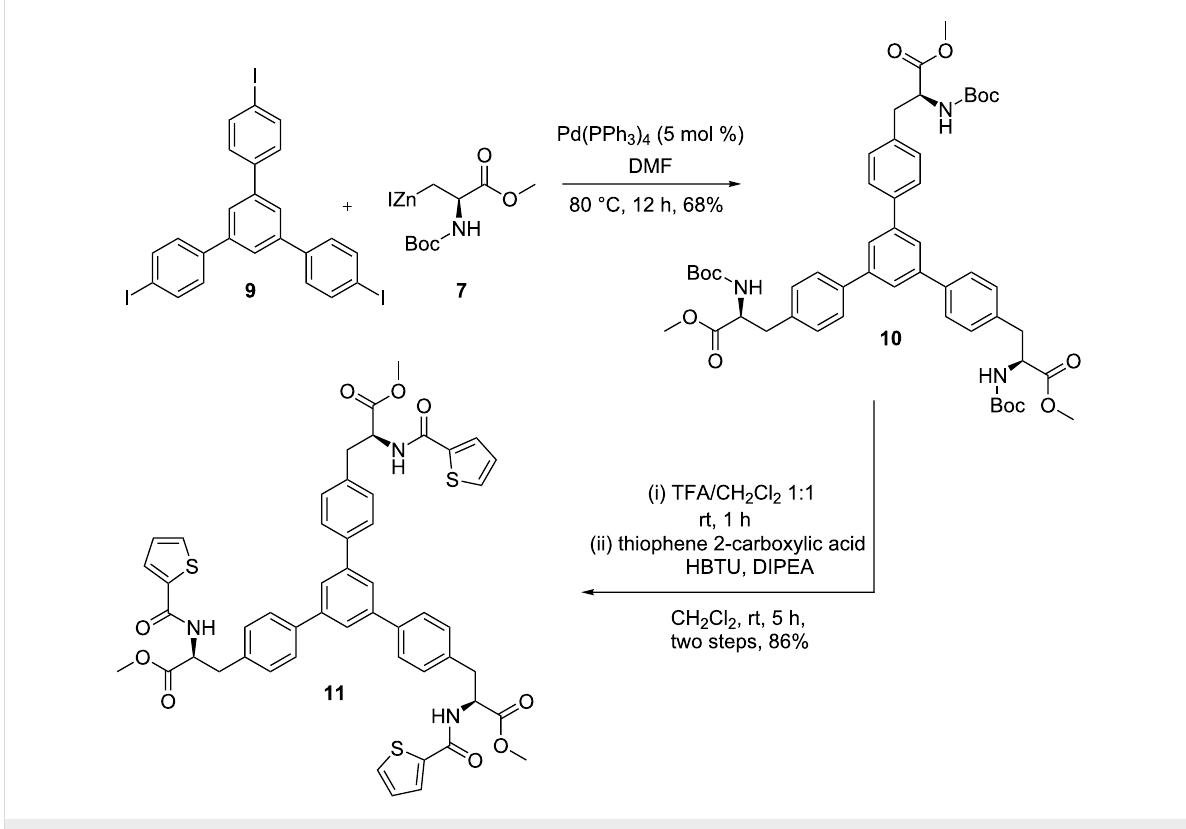
Scheme 3: Synthesis of compound 11 via Negishi cross-coupling reaction.